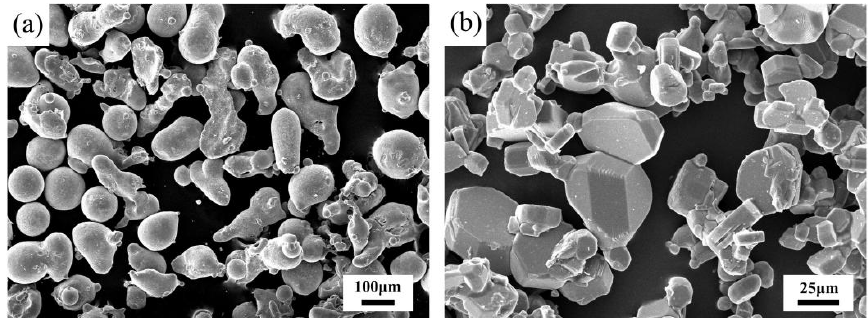
Figure 1. Morphology of the powder materials: ( a ) Ni60A; ( b ) TiB 2 .